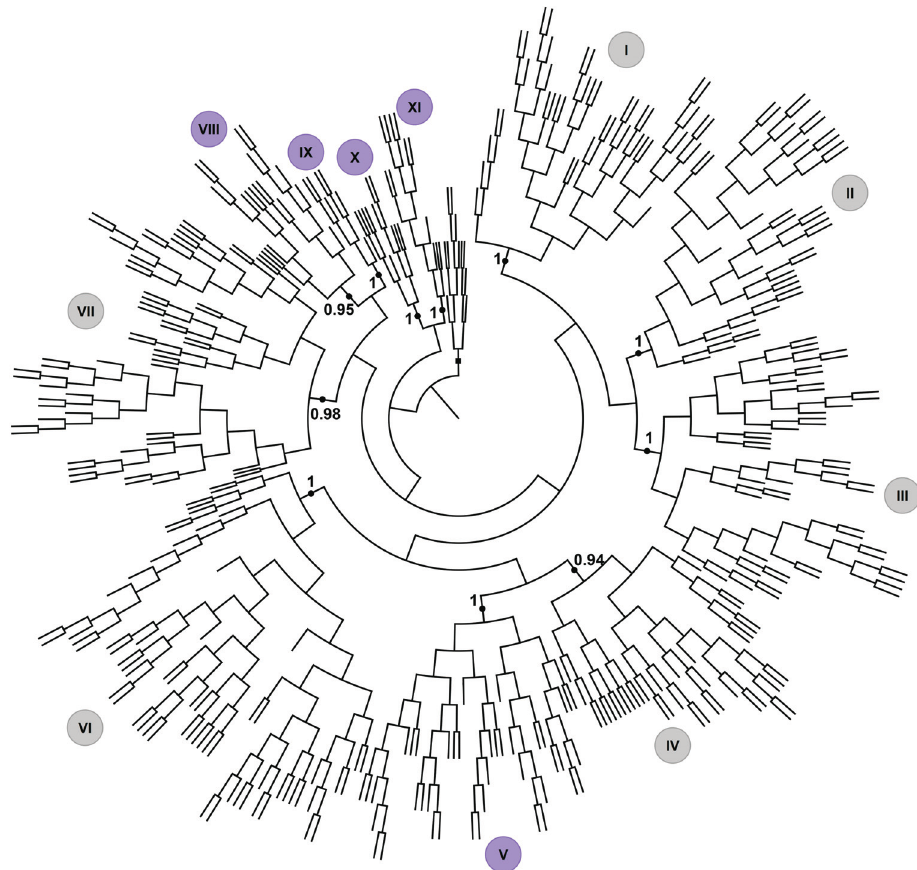
Figure 4 - Phylogenetic relationship of GRFs. Coding sequences of QLQ and WRC domains of K. nitens and land plants were used to generate a phylo- genetic tree reconstructed by Bayesian inference. Groups I to XI correspond to flowering plants, and the others correspond to algae and moss sequences. The dicot groups are colored in gray, whereas the monocot groups are colored in purple. Species, loci , and taxa terminologies are available in Table S2. A detailed tree is available in Figure